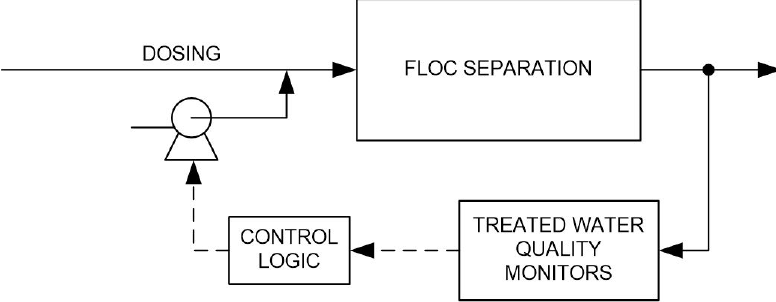
Figure 3. Sketch of a feed-backward control scheme based on finished water